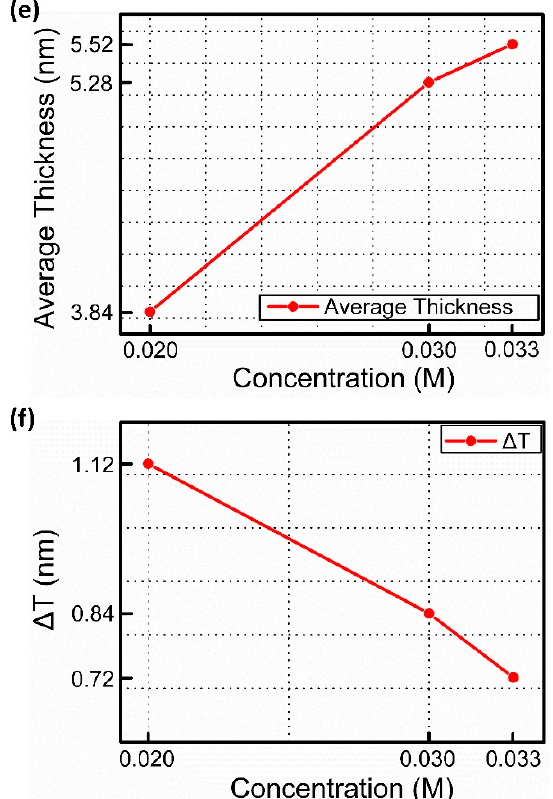
Figure 1. ( a – c ) Cross-sectional TEM images of 0.020, 0.030, and 0.033 M SnO 2 films, respectively. ( d ) Schematic diagram illustrating the definition of parameters and estimated ( e ) average thickness and ( f ) Δ T parameters.